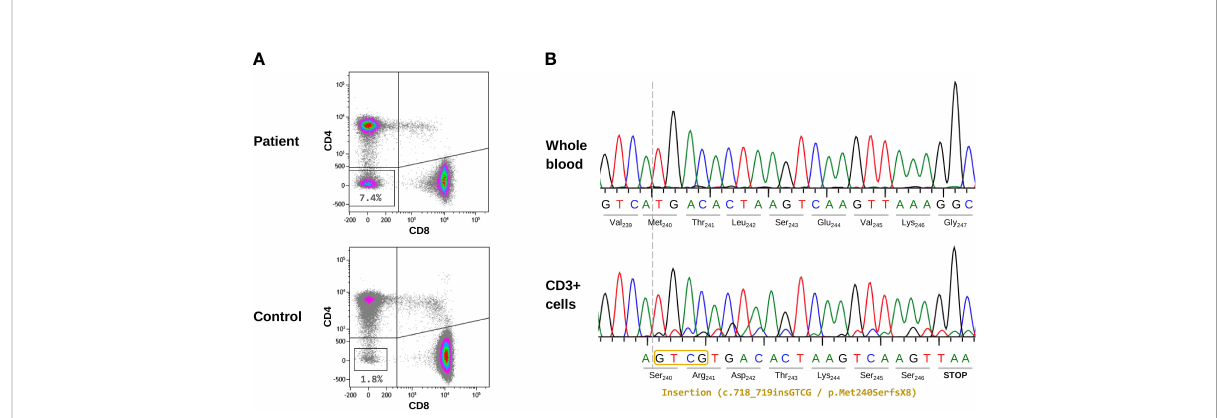
FIGURE 1 Cellular and molecular characterization of the patient ’ s samples. (A) Evaluation of TCR ab + CD4 - CD8 - T cells (DNTs) by fl ow cytometry. The index patient and a representative healthy donor are shown. Gating strategy: on CD3 + T cells, TCR ab positive cells were fi rst selected; next, CD4 and CD8 dot-plot analysis was performed. The lower-left quadrant contains DNT data (percentage of DNTs) is indicated. (B) Sanger sequencing results from the initial sample (2017). The upper panel corresponds to DNA extracted from whole blood where no somatic variant was detected. The lower panel shows the CD3 + enriched sample, where a double peak pattern appeared, indicating the presence of a 4-bp insertion